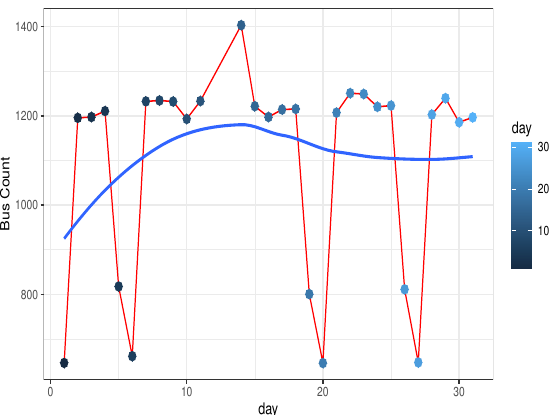
Figure 3. The average volume of the bus traffic count per day in the dense dataset.